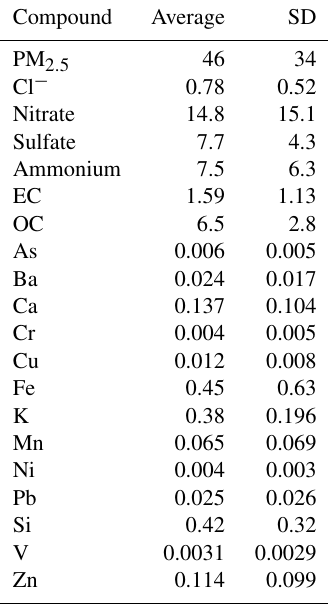
Table 1. Measured PM 2 . 5 major components (µgm − 3 ) used in the PMF analysis in this